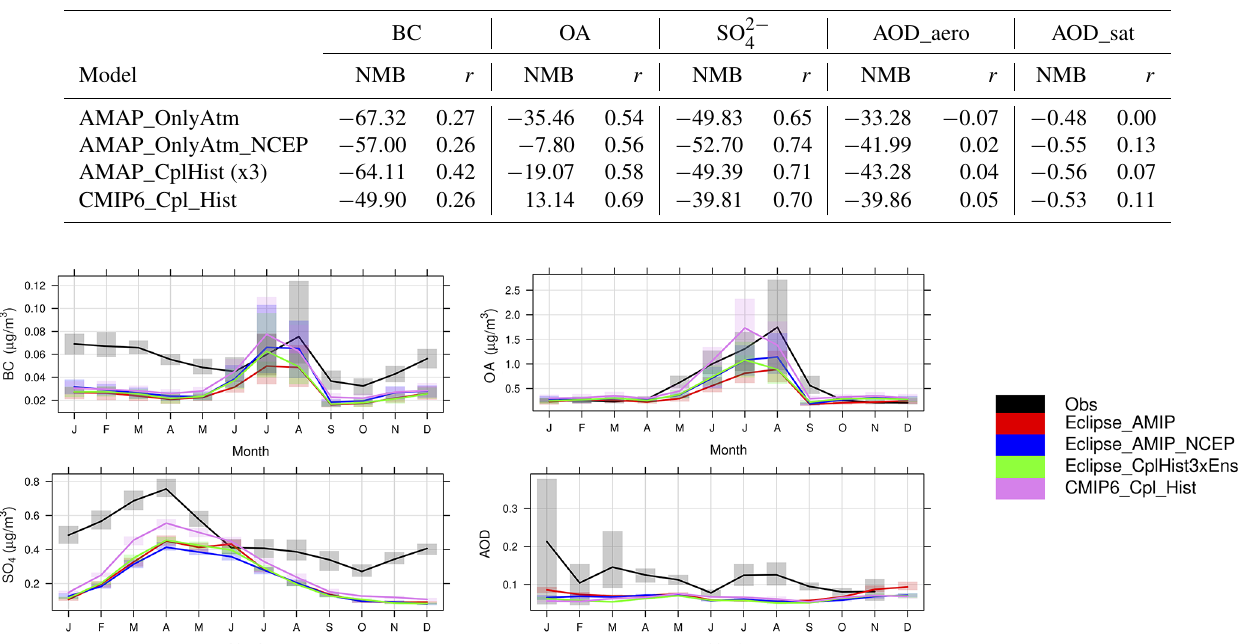
, and AERONET AOD at 550nm (2008/09– 4